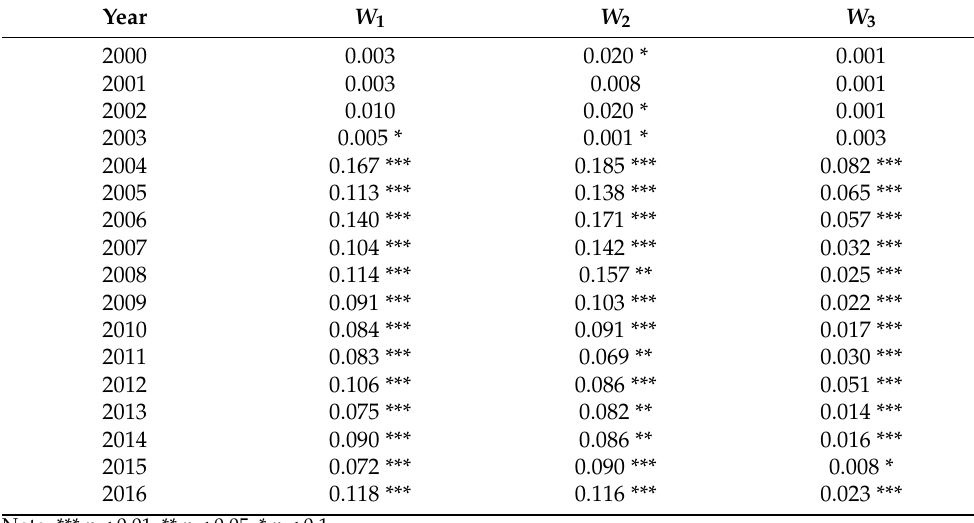
Table 11. Spatial correlation analysis: global Moran index by year.